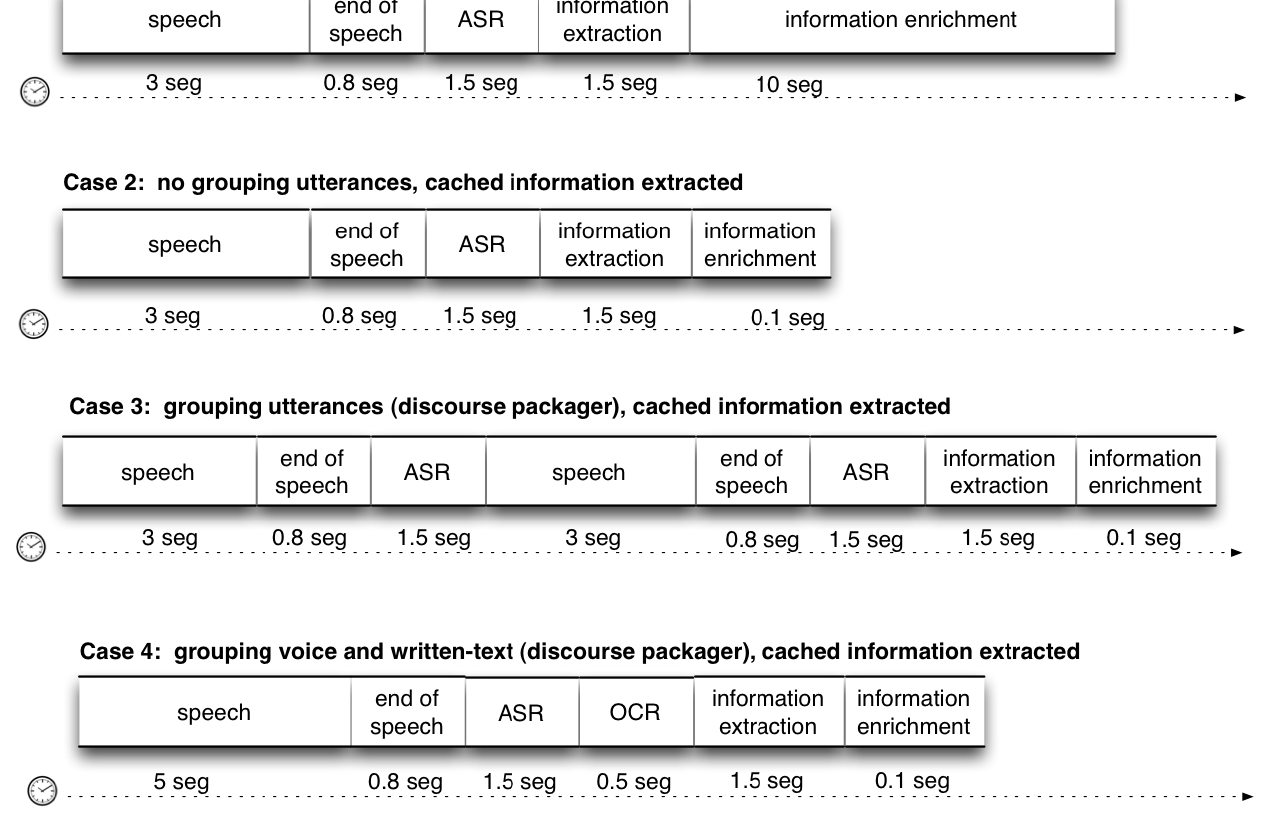
Figure 7. Timing information on several use cases. OCR, optical character